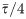
(a) Simulation results for N = 2, 3, 4, 5, 6, 7, 8 buses, respectively, serving M = 1 bus stop. The demand level is fixed at k = 1/16. (b) Simulation results for N = 2, 3, 4, 5, 6, 7, 8 buses, respectively, serving M = 12 bus stops. The demand level is fixed at k = 1/100. The analytical curves are for those serving M = 1 bus stop. The simulation points have average waiting times which are higher than their corresponding analytical curves, since these buses serve M = 12 bus stops. Furthermore, there are discrete jumps on the simulation points whenever an extra bus stop is present. (c) Graphs of the piecewise continuous curves for N = 2, 3, 4, 5 as given by Eq (18) with τ¯/4 subtracted away, together with the corresponding smooth curves Eq (18) that pass through the boundary points of each line segment, for the respective N. These smooth curves are hyperbolas, and approach an “L”-shaped asymptotic curve as N → ∞. (d) Legend for (a) and (b).